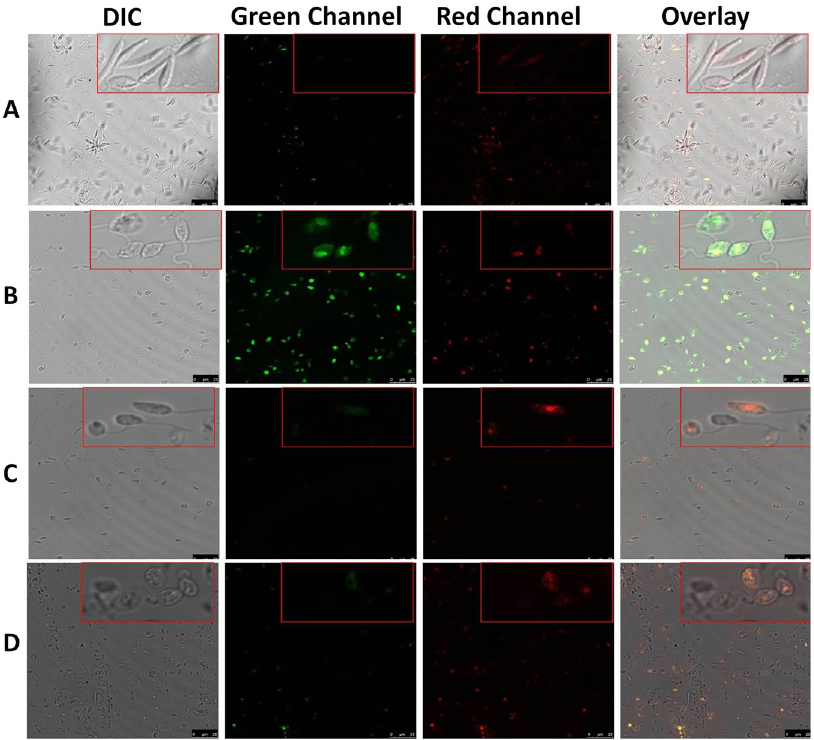
Figure 5. Laser Scanning Confocal Microscopy images of L. donovani promastigotes showing the aggregation and monomer forms of Mitocapture TM dye. L. donovani promastigotes were treated for 6 hr, stained with Mitocapture TM dye and image was captured by Confocal Microscopy (63x magnification). Increase in red fluorescence indicated the normal mitochondrial membrane whereas increase in green fluorescence showed the alteration in transmembrane potential of mitochondria. ( A ) Control promastigotes treated with 0.2% DMSO. ( B ) Promastigotes induced with 25 µ M of miltefosine. ( C ) Cells treated with 20 µ M of TNP-470 and ( D ) Miltefosine induced promastigotes treated by TNP-470 for 6 hr. (DIC represents differential interference contrast microscopy).